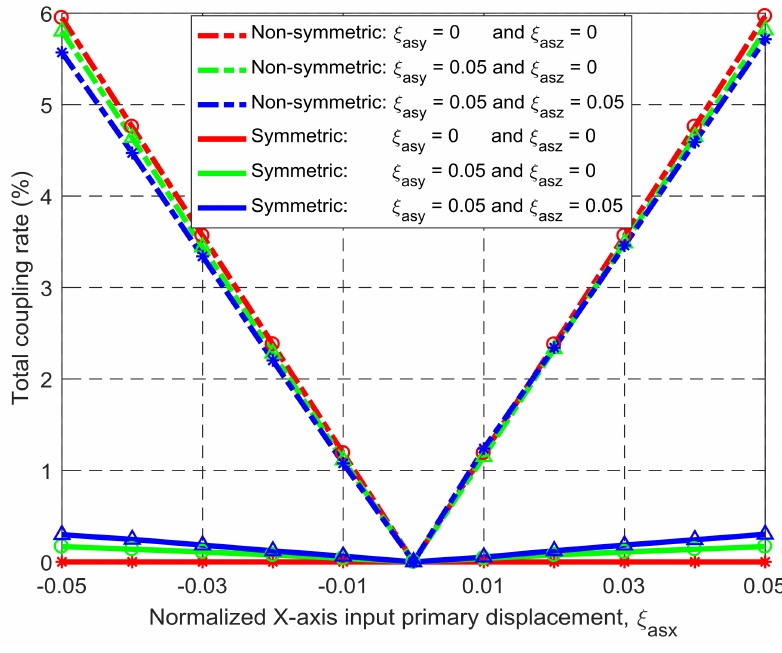
Figure 12. Coupling comparison between the symmetric and non-symmetric XYZ CPMs shown in Figure 3a,h (Symbols, ‘*’, ‘ (cid:52) ’ and ‘ ’, in this figure are data (cid:35)